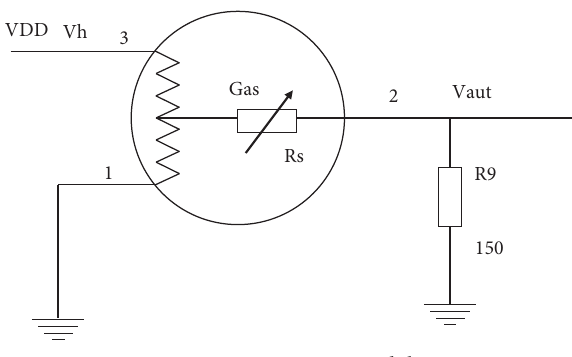
Figure 3: Gas sensor